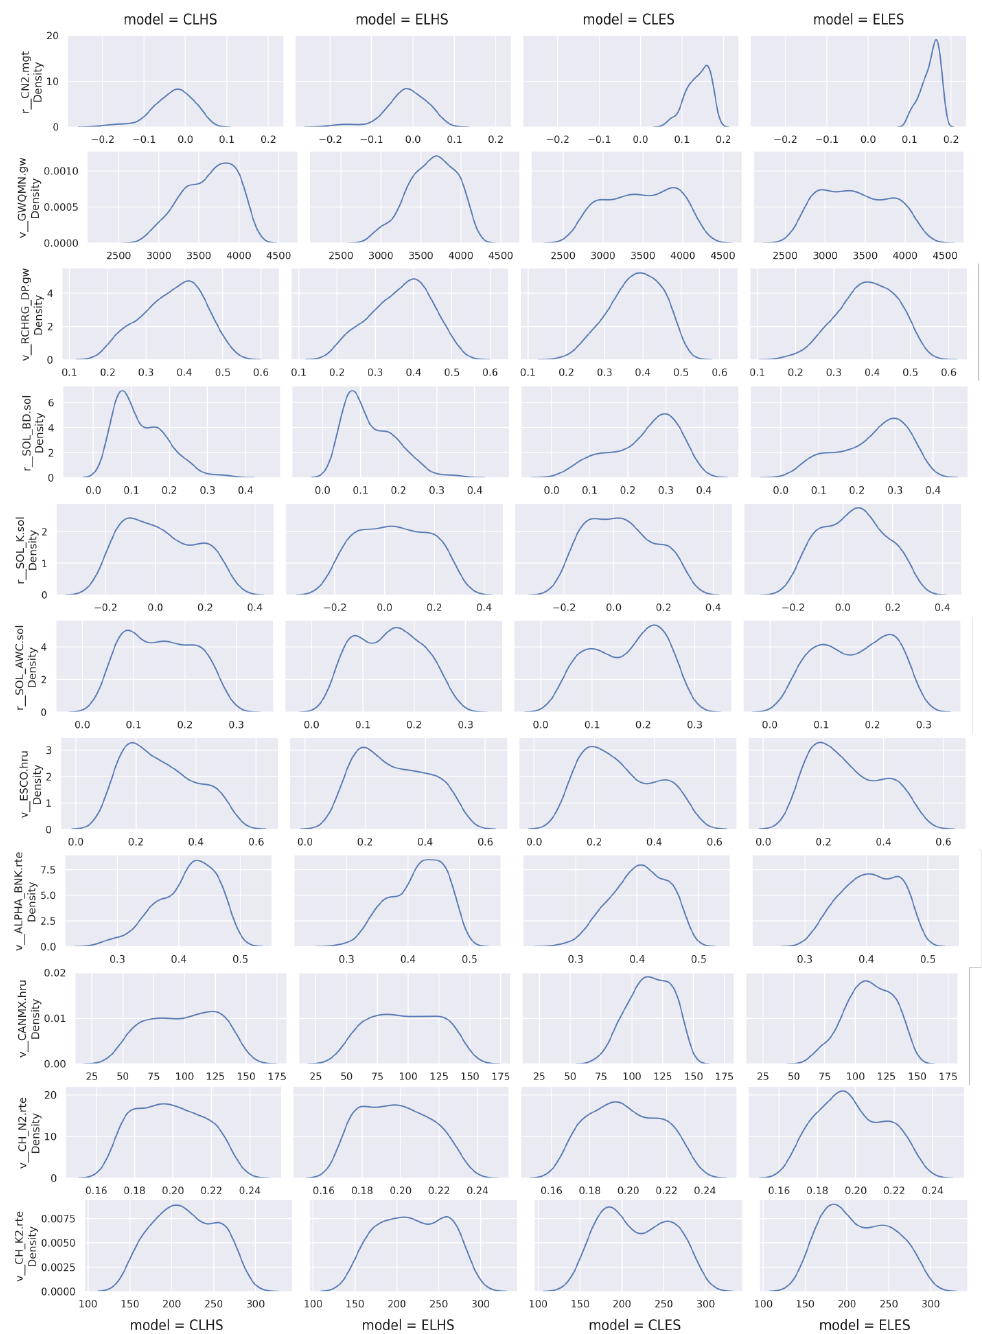
Figure A6. Density plots of parameter value distribution in top 5% performing simulations in uncertainty analysis with the common parameter list. The parameter descriptions and units are listed in Table